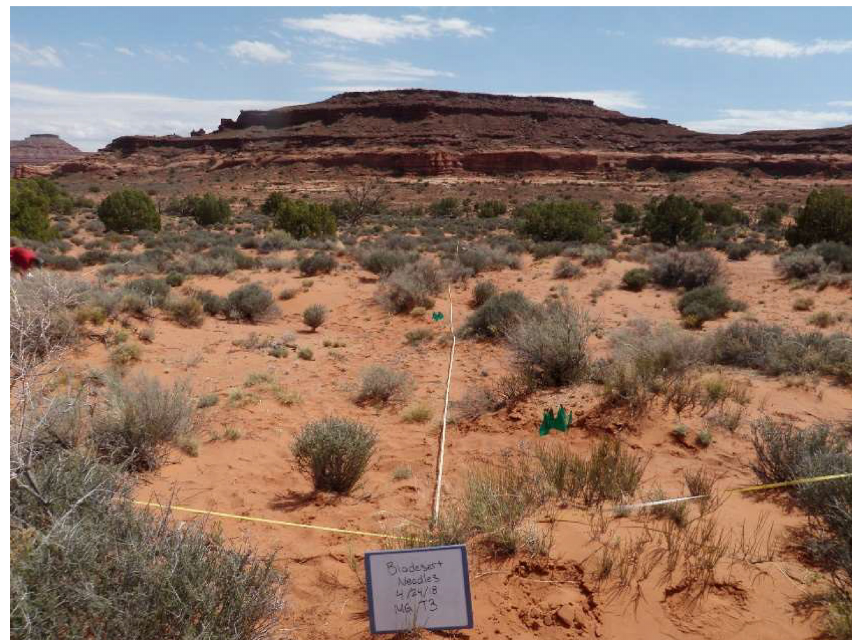
Figure 5. Example of a transect line placed in the field. Photograph by Matthew